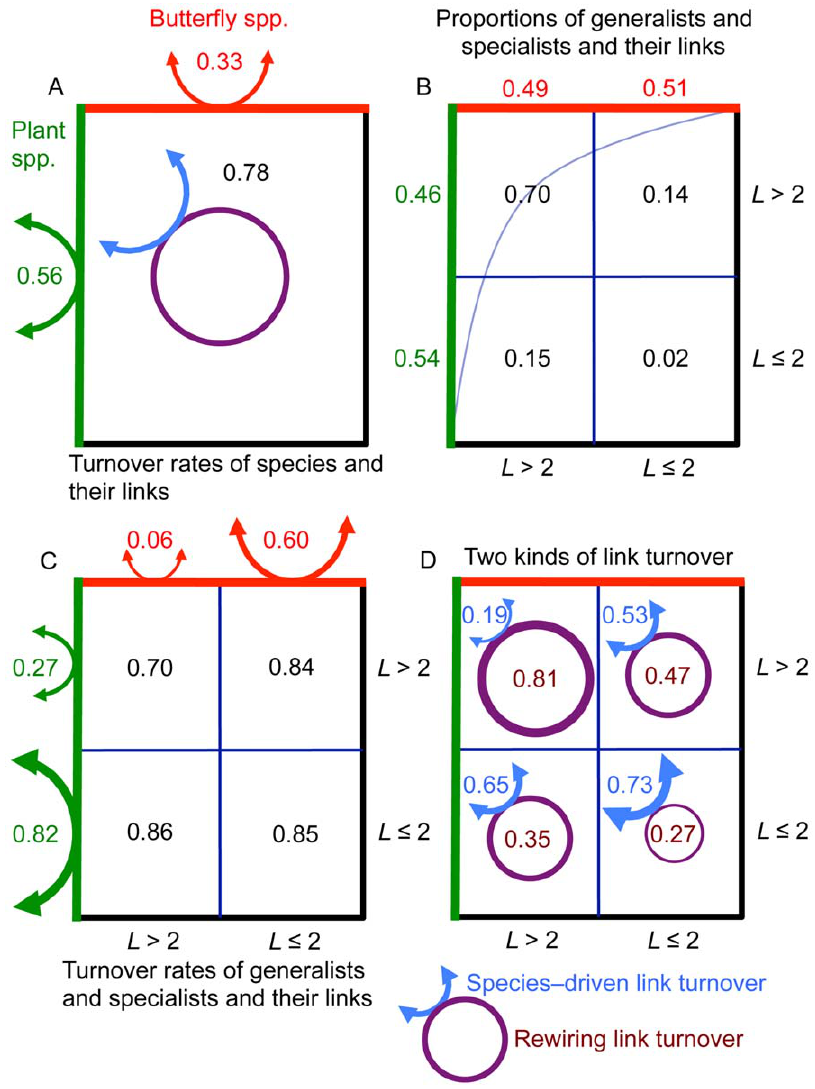
Figure 3. Numbers and annual turnover rates of species and links. Nested matrix between interacting butterfly species and their nectar plant species. The matrix is divided into quadrants, according to L . 2 (generalists) or L # 2 links (specialists). ( A ) Overall average annual turnover rates for species and their links. Proportions of plant (green double arrow) and butterfly species turnover (red double arrow). Proportions of total link turnover attributed to rewiring (mauve circle) and species turnover (blue double arrow). ( B ) Proportions of generalist and specialist plant (green figures) and butterfly species (red figures) and their links in the 12-yr pooled matrix. The curved line is the nestedness isocline. ( C ) Average annual turnover rates for generalist and specialist plants (green double arrows) and butterfly species (red double arrows) and their links. ( D ) Proportions of total link turnover attributed to rewiring (mauve circles) and species turnover (blue double arrows).